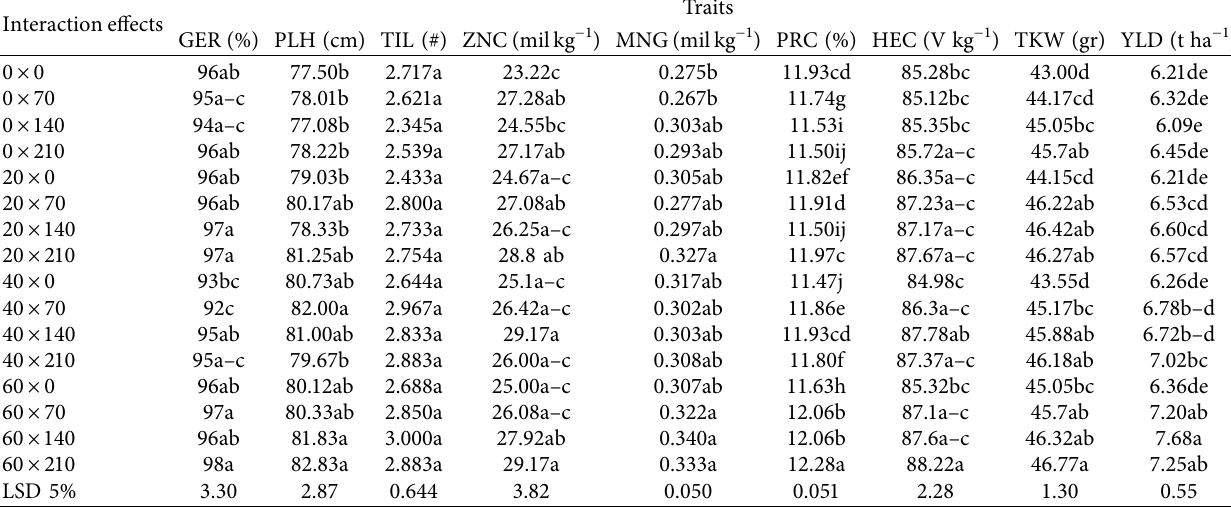
Table 3: Comparison of the traits measured in the examination of different levels of zinc and magnesium in bread wheat based on combined analysis. Interaction effects